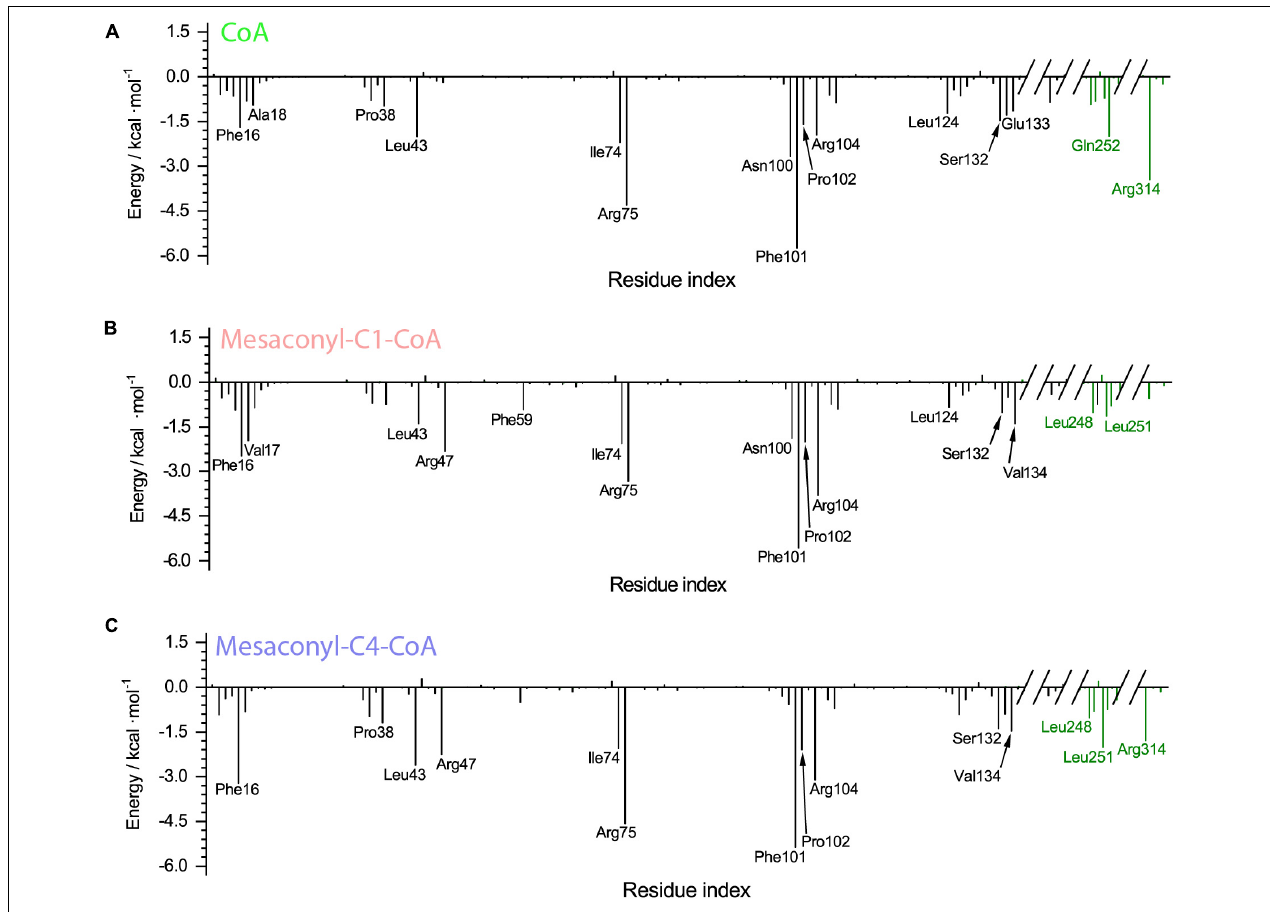
FIGURE 5 | The per-residue decomposition of the binding free energies of R. castenholzii MCT in binding with CoA (A) , mesaconyl-C1-CoA (B) , and mesaconyl-C4-CoA (C) . The binding free energy values (kcal mol − 1 ) are plotted against the amino acid numbers to show their